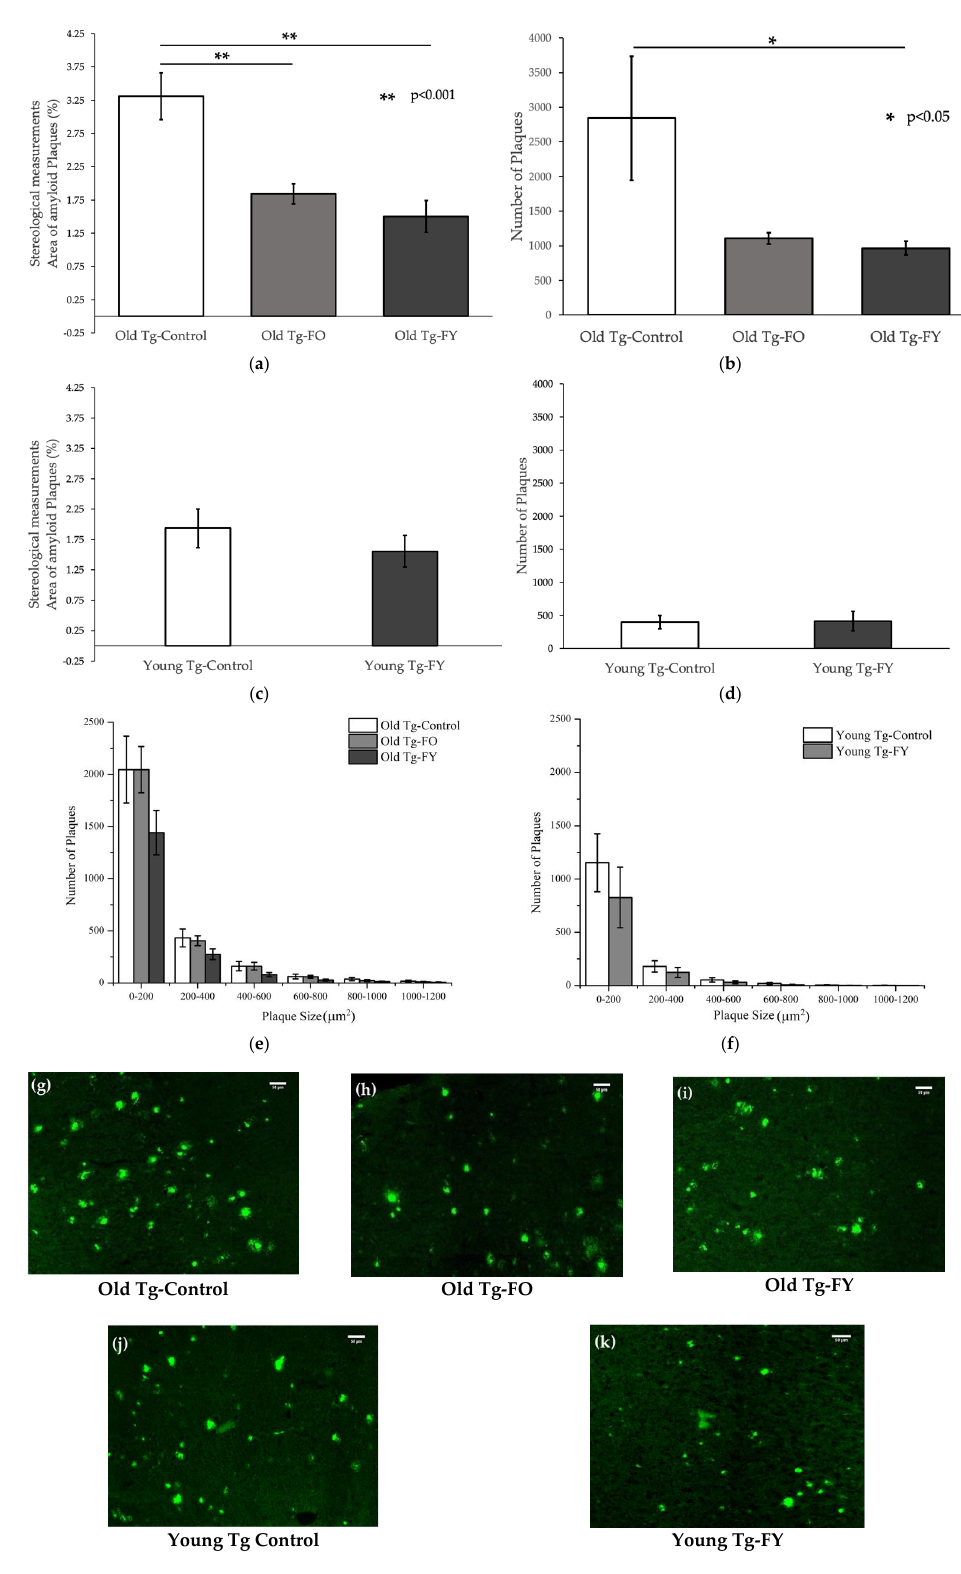
Figure 5. FMT resulted in decreased amyloid plaque burden in treated mice as seen in Thioflavin S – stained brain sections. ( a ) Old Tg-FO and Old Tg-FY both had reduced percentage amyloid plaque with a nearly 2-fold decrease in Old Tg-FO ( p < 0.01) and Old Tg-FY mice ( p < 0.01) as well as ( b ) fewer plaques in both groups of treated mice (Old Tg-FY p < 0.05). ( c ) Young Tg-FY mice al- so showed a reduced percentage area of amyloid plaques with ( d ) no difference seen in the num- ber of plaques. ( e ) Old Tg-FY mice showed decreased numbers of varying plaque sizes as com- pared to both Old Tg-Control and Old Tg-FO while ( f ) Young Tg-FY also showed decreased num- bers of all plaque sizes compared to Young Tg-Controls. ( h ) Old Tg-FO mice and ( i ) Old Tg-FY had lesser amyloid plaque burden compared to ( g ) Old Tg-Controls. Mature, compact plaques were more diffuse with less defined outlines following FMT. Although ( k ) Young Tg-FY mice did not demonstrate decreased plaque burden compared to ( j ) Young Tg-Control mice, plaque disper- sal appeared similar to the Old treated mice. Data is presented as mean ± SEM. Scale bar = 50μm. Young Tg-FY: Young Transgenic-Fed Young, Young Tg-Control: Young Transgenic Control, Old Tg-FY: Old Transgenic-Fed Young, Old Tg-FO: Old Transgenic-Fed Old, Old Tg-Control: Old Transgenic Control 3.3. Cognition Score The decreasing trend of Aβ plaque load across Old Tg -FO and Old-Td-FY is in- versely correlated with the trend of improved cognition, which was measured as a com- pounded Cognition Score of the behavioral study results (CS), indicating the importance of donor age in decreasing amyloid pathology and improving cognition (Figure 6a). The resulting correlation showed that a lower plaque burden in Old Tg-FO and Old Tg-FY resulted in improved cognition compared to Old Tg-Control. Interestingly, Old Tg-FY had a much higher CS and lower amyloid plaque loading (APL) compared to Od Tg-FO, indicating that donor age influences FMT outcomes. Young Tg-FY mice demonstrated marginally decreased APL and CS compared to controls (Figure 6b). The decrease in CS in the Young Tg-FY mice does not mirror the effects seen in older Tg mice and is reflec- tive of the significantly fewer entries made into the open arm of the EMP by young WT mice ( p = 0.001), an anxiety-associated feature.